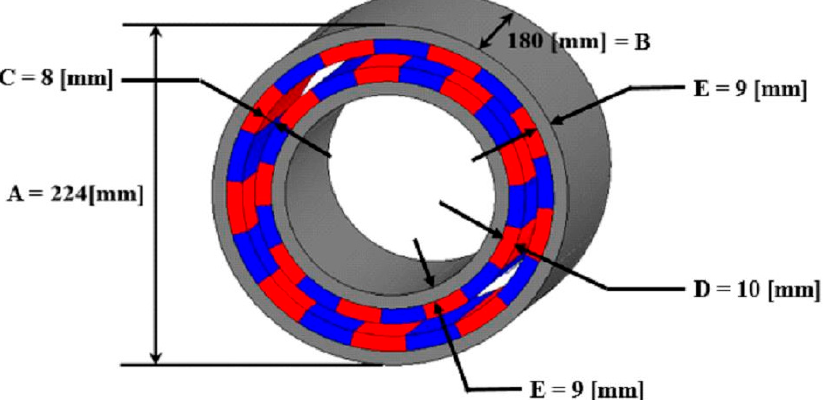
Figure 24. Final Design parameters of the 10 kW Magnet coupler. The dimensions from Table 7 are labeled here.